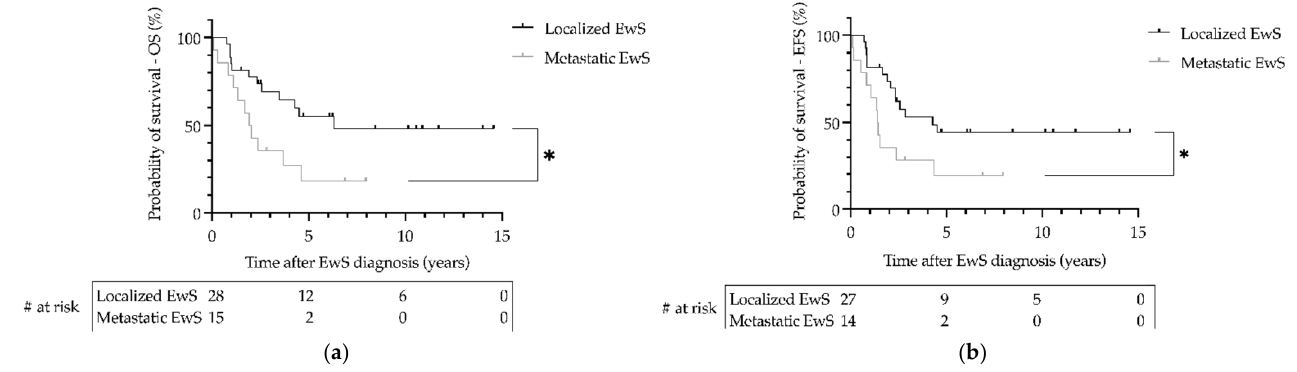
Figure 3. Survival of patients withEwing sarcoma (EwS) as secondary malignant neoplasms as a function of metastatic status at diagnosis in the EICESS 92, Euro-E.W.I.N.G. 99, and EWING 2008 trials. ( a ) Overall survival (OS) and ( b ) event-free survival (EFS) were calculated using the Kaplan–Meier method. * ( a ) p = 0.02, ( b ) p = 0.03. # at risk—numbers at risk.